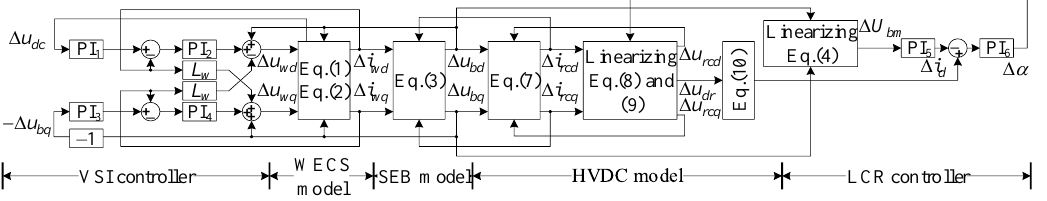
Figure 11. Small-signal model of the system.